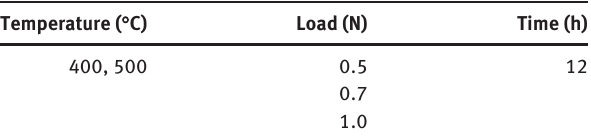
Table 1 TMA settings to study the AMC resistance to